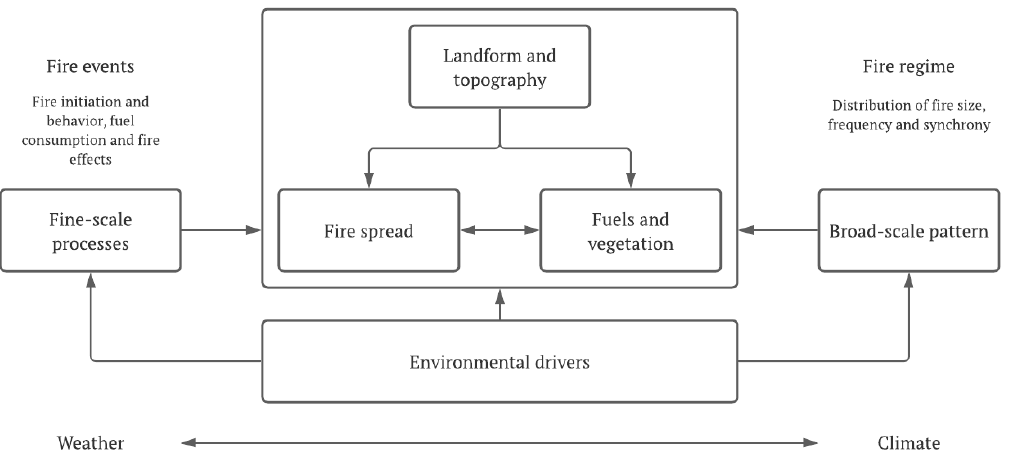
Figure 4. Cross-scale interactions of pattern and process in fire regimes. Environmental drivers of weather and climate, interacting with landform, set the overall template for individual fire events and fire regimes. Interactions between fire spread and vegetation determine the properties of fires at fine scales, while creating broad-scale landscape pattern [33] .